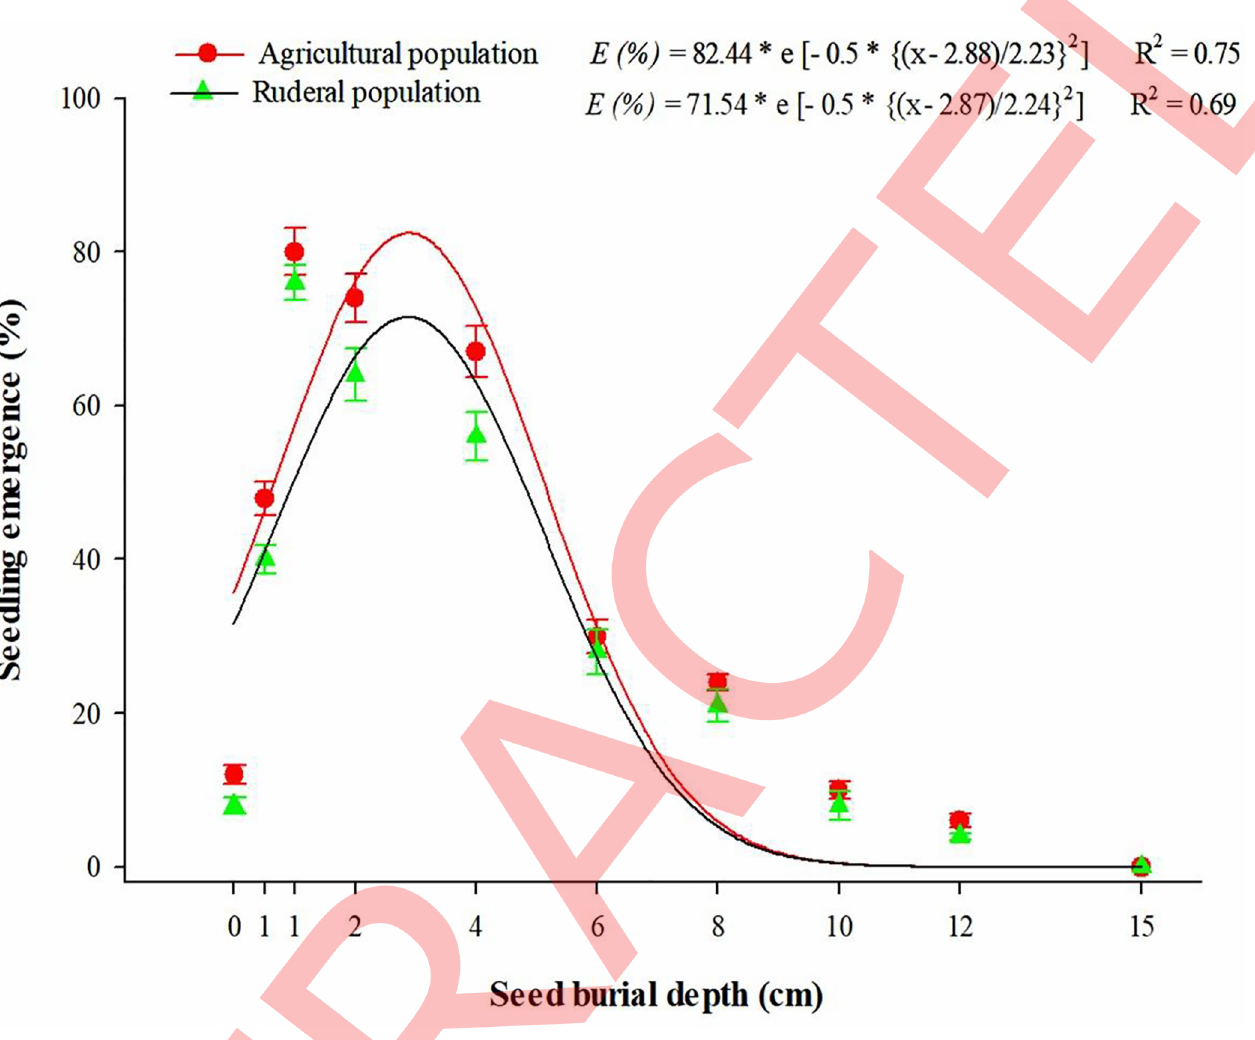
Fig 6. The influence of different seed burial depths on seedling emergence percentage of ruderal and agricultural populations of Xanthium strumarium L.